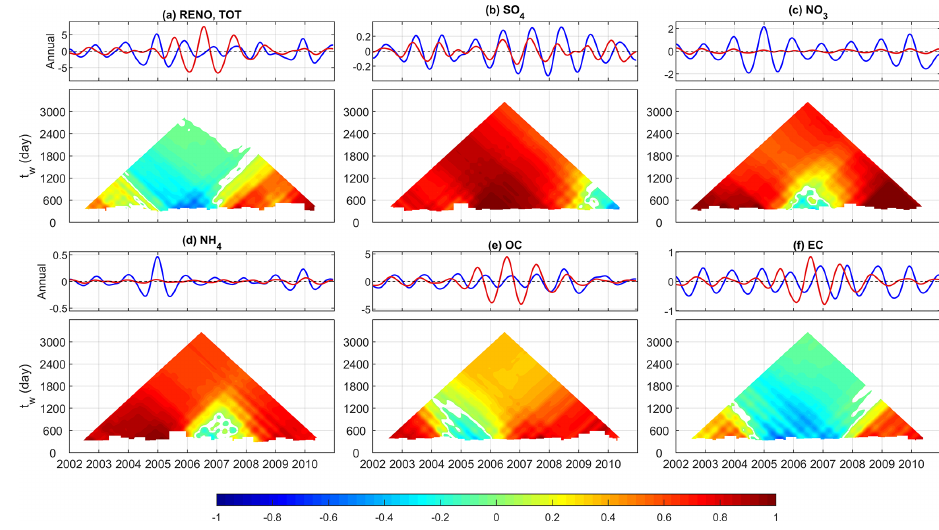
Figure 8. Same as in Fig. 7 for Reno, NV, except that (d) represents NH 4 rather than